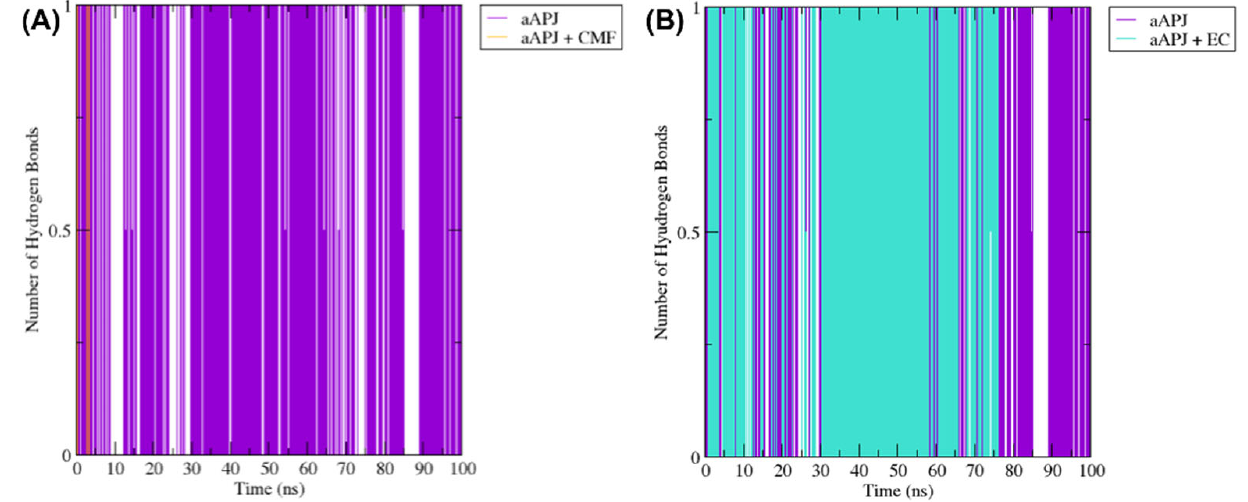
Figure 10. The H-bond plot shows the evolution of the hydrogen bonds formed by the TM5 Y221 residue and the TM7 Y309 residue. ( A ) When the receptor is alone (aAPLNR—purple lines), we see how these two residues form the hydrogen bond in practically the entire trajectory. However,